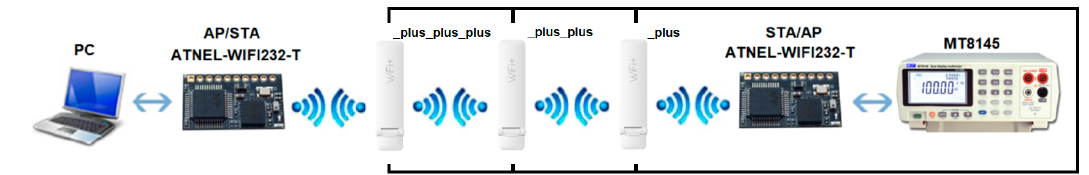
Figure 13. Extended wireless communication channel with three repeaters.